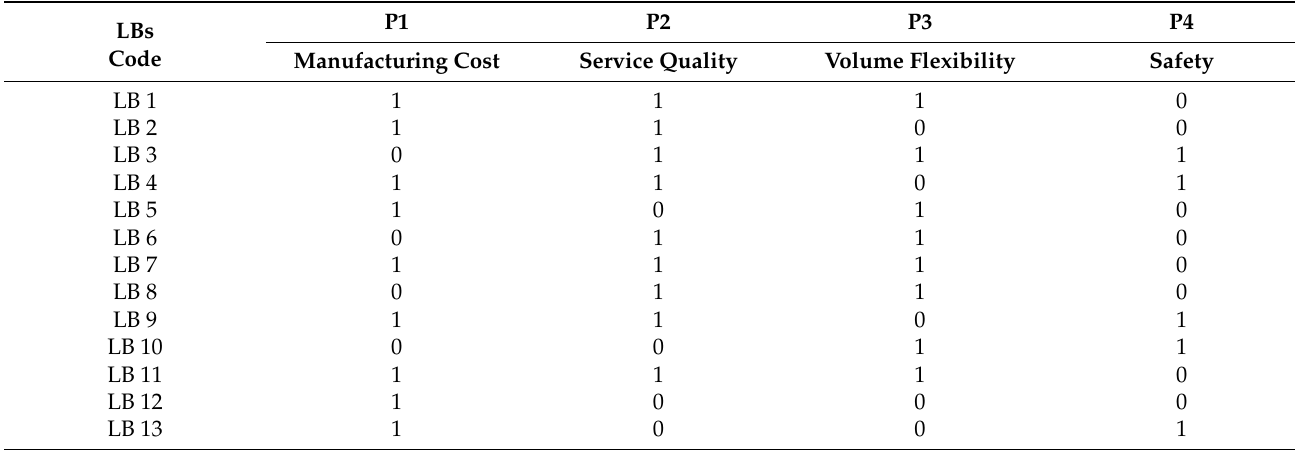
Table 7. Cross-interaction matrix (CIM) of LBs and lean performance criteria.